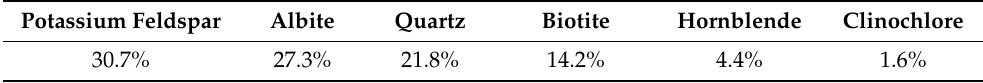
Table 1. Mineral composition of granite used in the experiments.